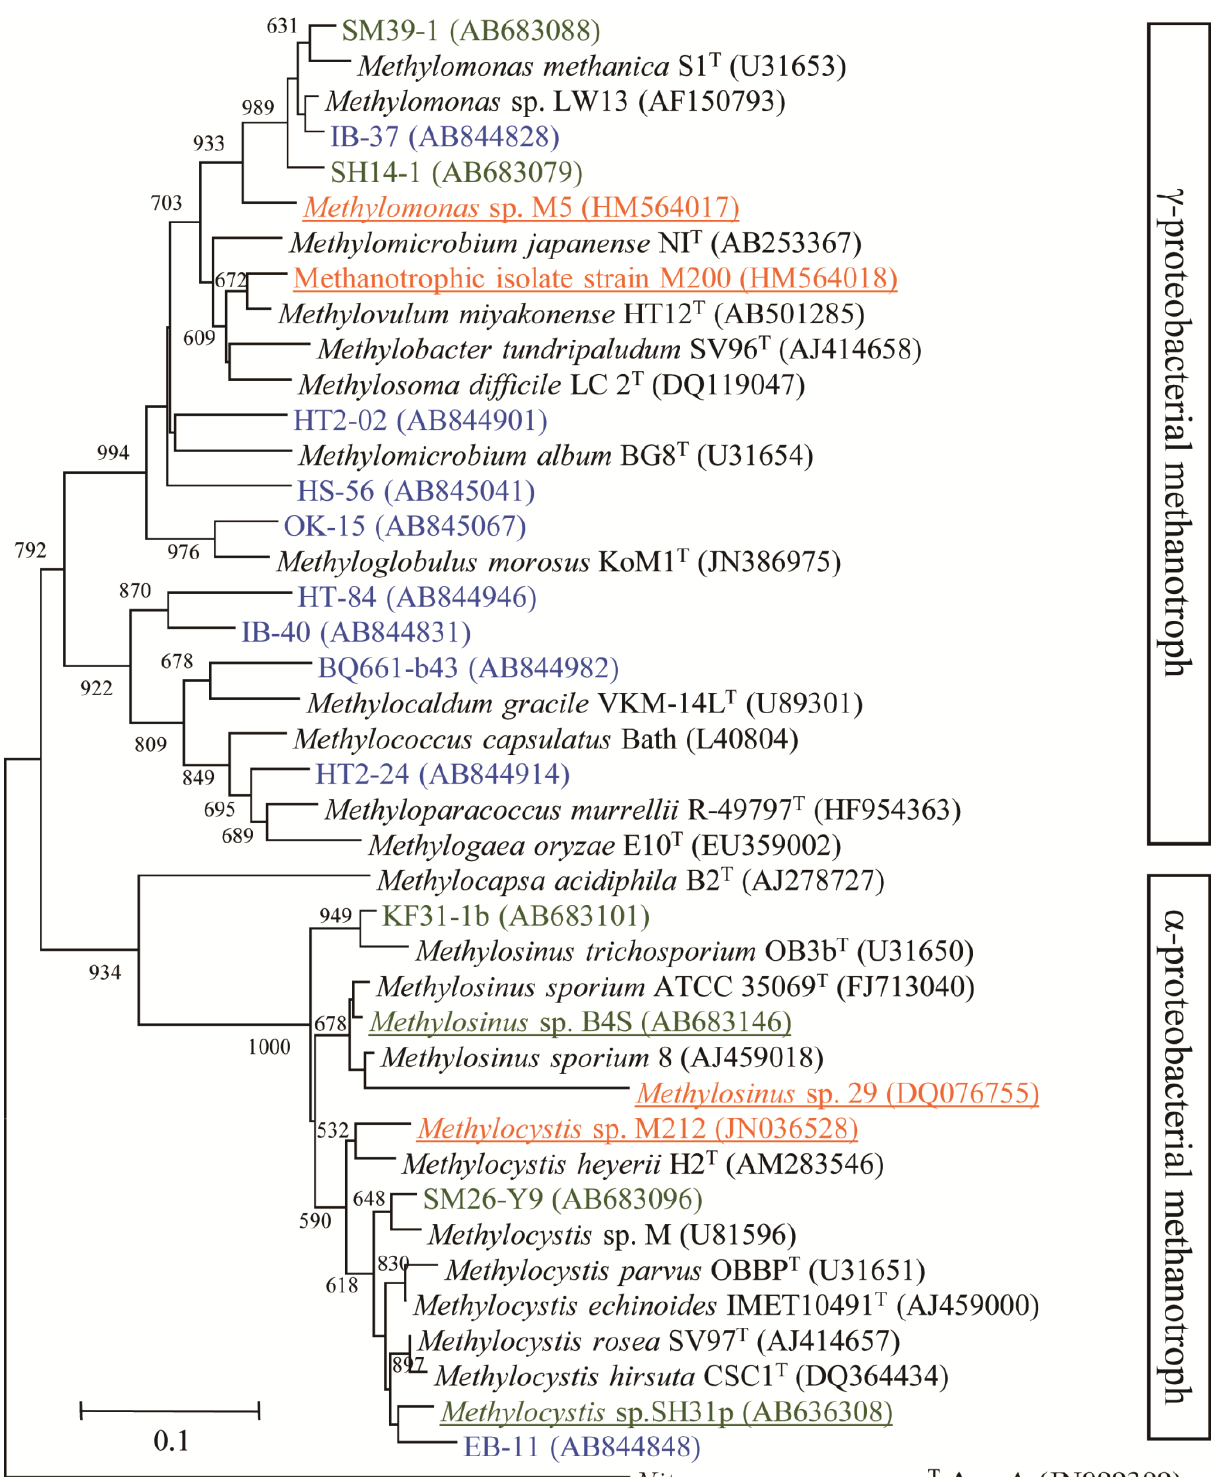
Figure 1. Phylogenetic tree of PmoA sequences from plant-derived methanotrophic isolates (bold letters) and methanotrophic clones retrieved from cultures. Methanotrophs that originated from plant samples are shown in colored letters: Plant tissues in the phyllosphere (green, [50]), macrophytic algae (blue, [56]) and Sphagnum mosses (orange, [57]). Bar, 0.1 substitutions per amino acid